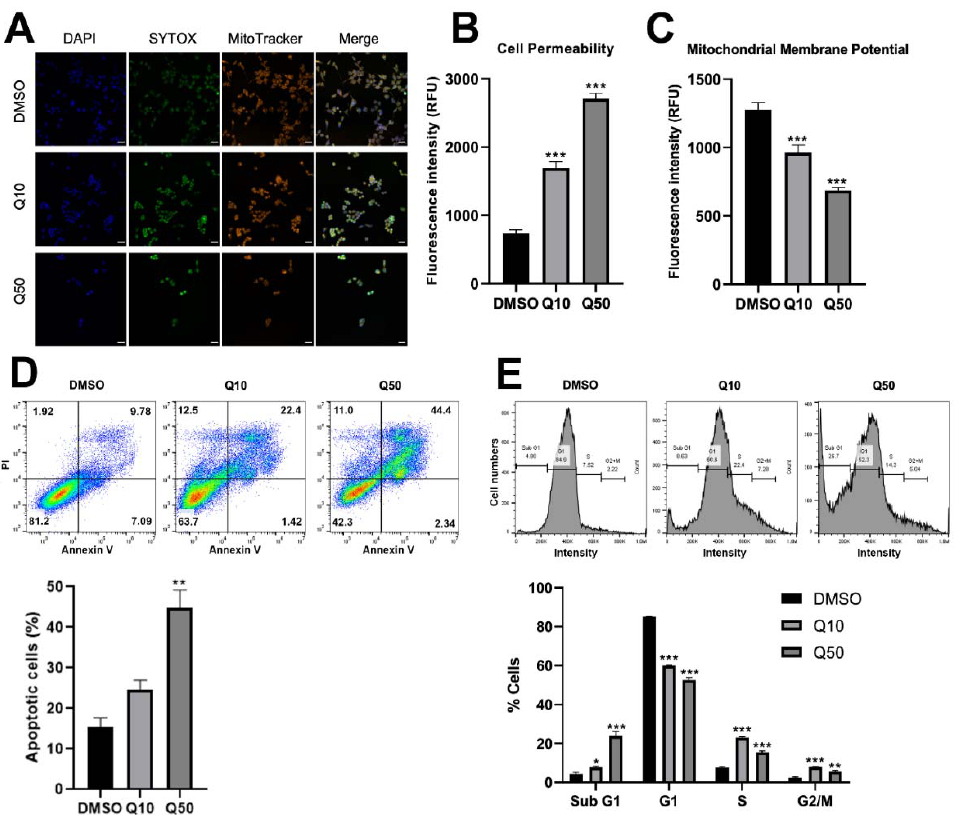
Figure 4. Quercetin induced apoptosis and cell cycle arrest in BCPAP cells. ( A ) BCPAP cells were subjected to high-content screening using the CellInsight CX7 LZR High-Content Screening (HCS) Platform (Thermo Fisher Scientific, Waltham, MA, USA), and representative images are shown. Cells were stained with 1 µ g/mL Hoechst 33342, 100 nM SYTOX ® Green Nucleic Acid Stain (green), and 25 nM MitoTracker ® Orange CMTMRos (orange) in Hanks’ Balanced Salt Solution (HBSS) for 30 min. DMSO, vehicle; Q10, 10 µ M quercetin; Q50, 50 µ M quercetin. Magnification = 200 × , scale bar = 200 µ m. CellInsight CX7 LZR High-Content Screening (HCS) Platform data were quantified and presented as changes in cell permeability ( B ) and mitochondrial membrane potential ( C ) as measured by the average intensities of SYTOX and MitoTracker. Values are expressed as the mean ± the standard error of the mean (SEM). *** p < 0.001.( D ) Apoptosis analysis using Annexin V/ propidium iodide (PI) staining. DMSO, vehicle; Q10, 10 µ M quercetin; Q50, 50 µ M quercetin. The bottom graph represents the percentage of cells in the early and late apoptotic populations. Results are representative of three independent experiments. ** p < 0.01. ( E ) Cell cycle analysis using PI. The representative graph is shown at the top. The bottom graph indicates the different cell cycle populations in the presence of quercetin. Results are representative of three independent experiments. * p < 0.05, ** p < 0.01, and *** p < 0.001.